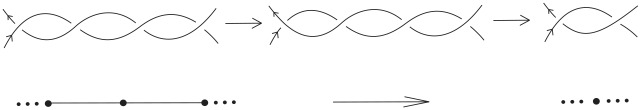
Flipping a crossing followed by a Reidemeister move II reduces the number of Seifert circles by two, and corresponding to a special contraction on the corresponding Seifert graph.